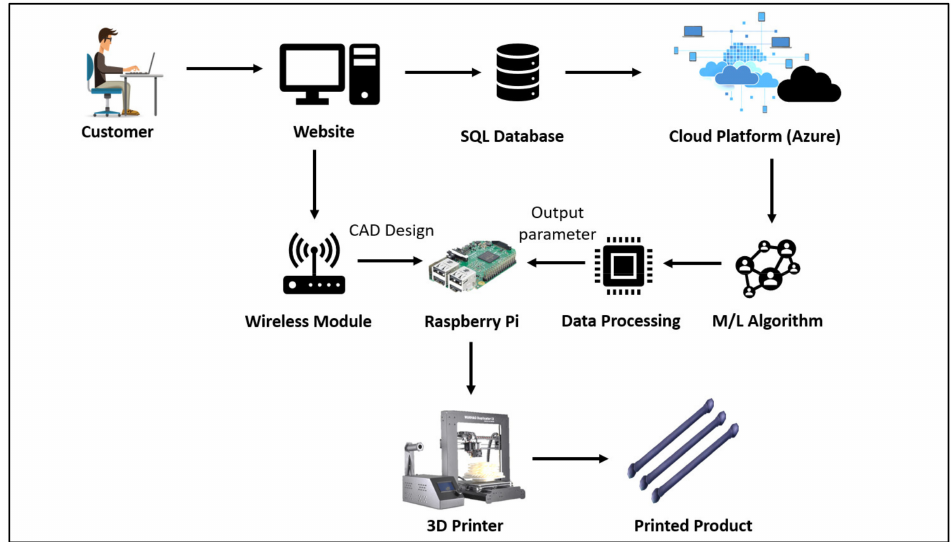
Figure 5. Framework for cloud-based DM (digital